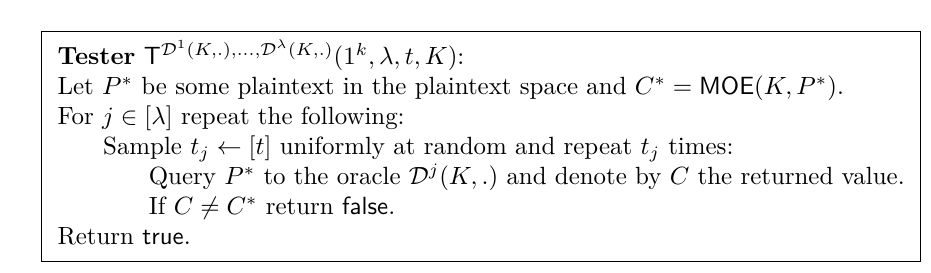
Figure 3: The tester T of the MOE construction.